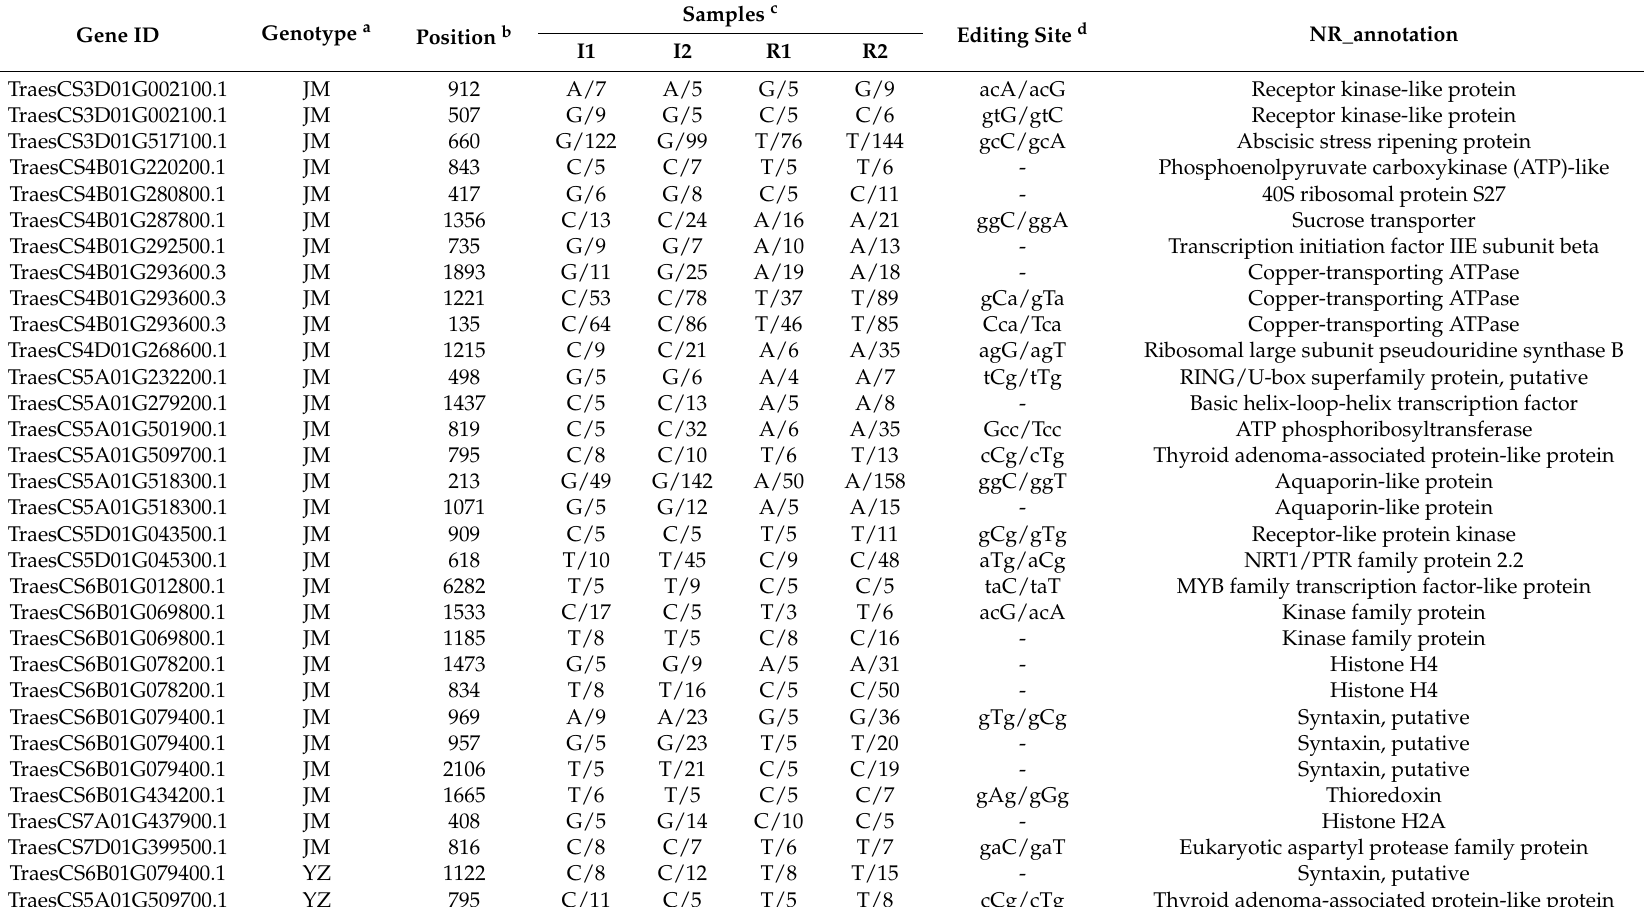
Table 2. The drought-responsive RNA editing sites identified in